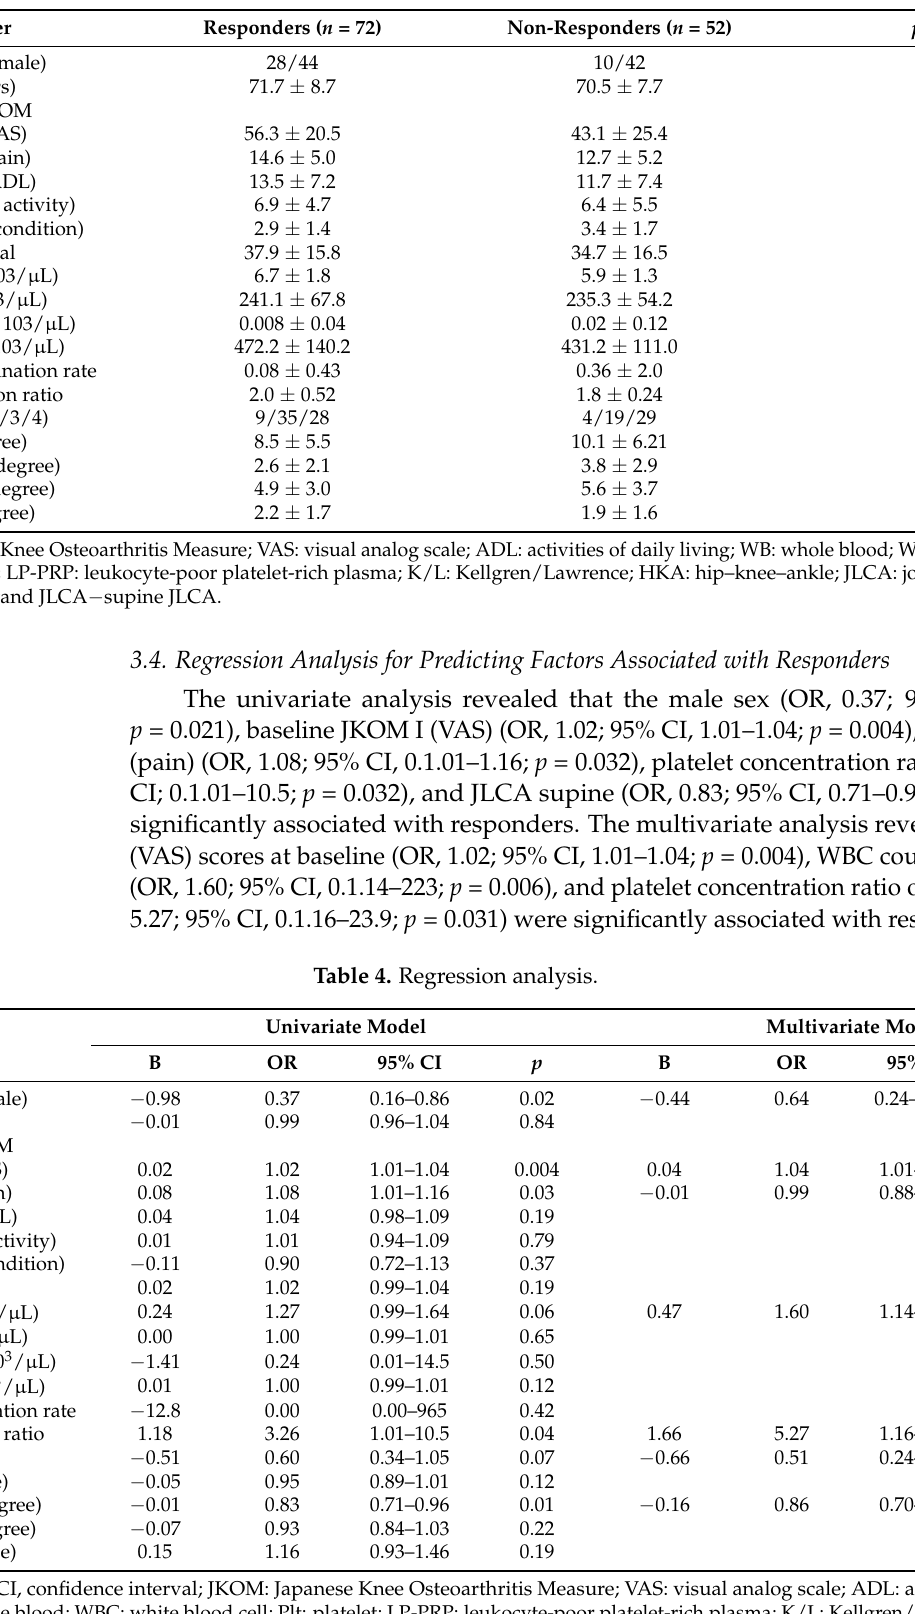
Table 3. Baseline characteristics of the responders and non-responders.